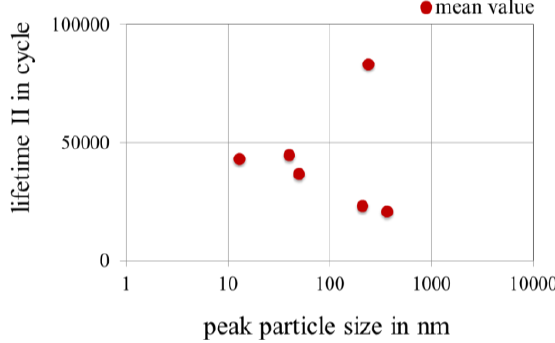
Figure 23. Effect of peak particle size in powder. Number of measurements: 86.